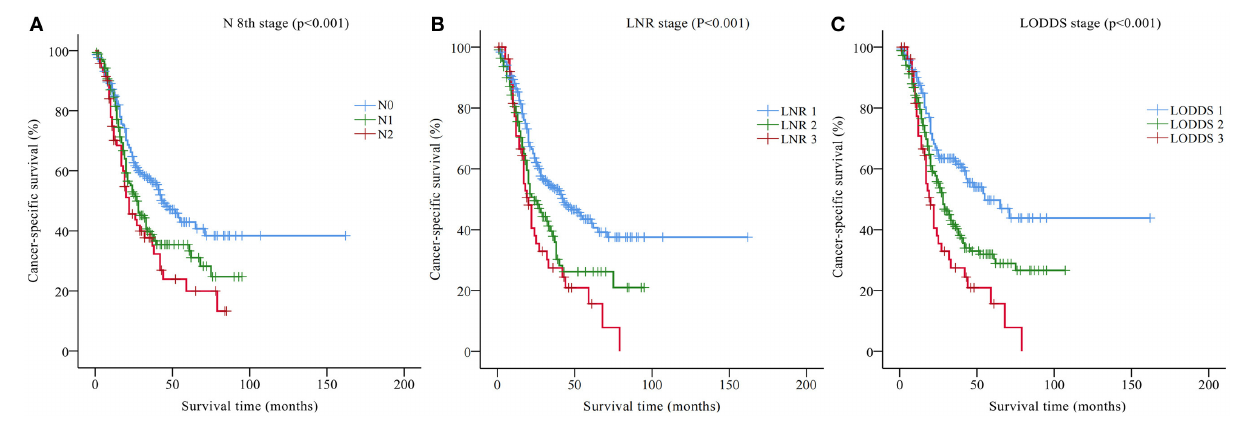
FIGURE 1 | Kaplan-Meier CSS curves stratified by (A) N 8th stage, (B) the LNR stage, and (C) the LODDS stage. CSS, cancer-specific survival; LNR, lymph node ratio; LODDS, log odds of positive lymph nodes.